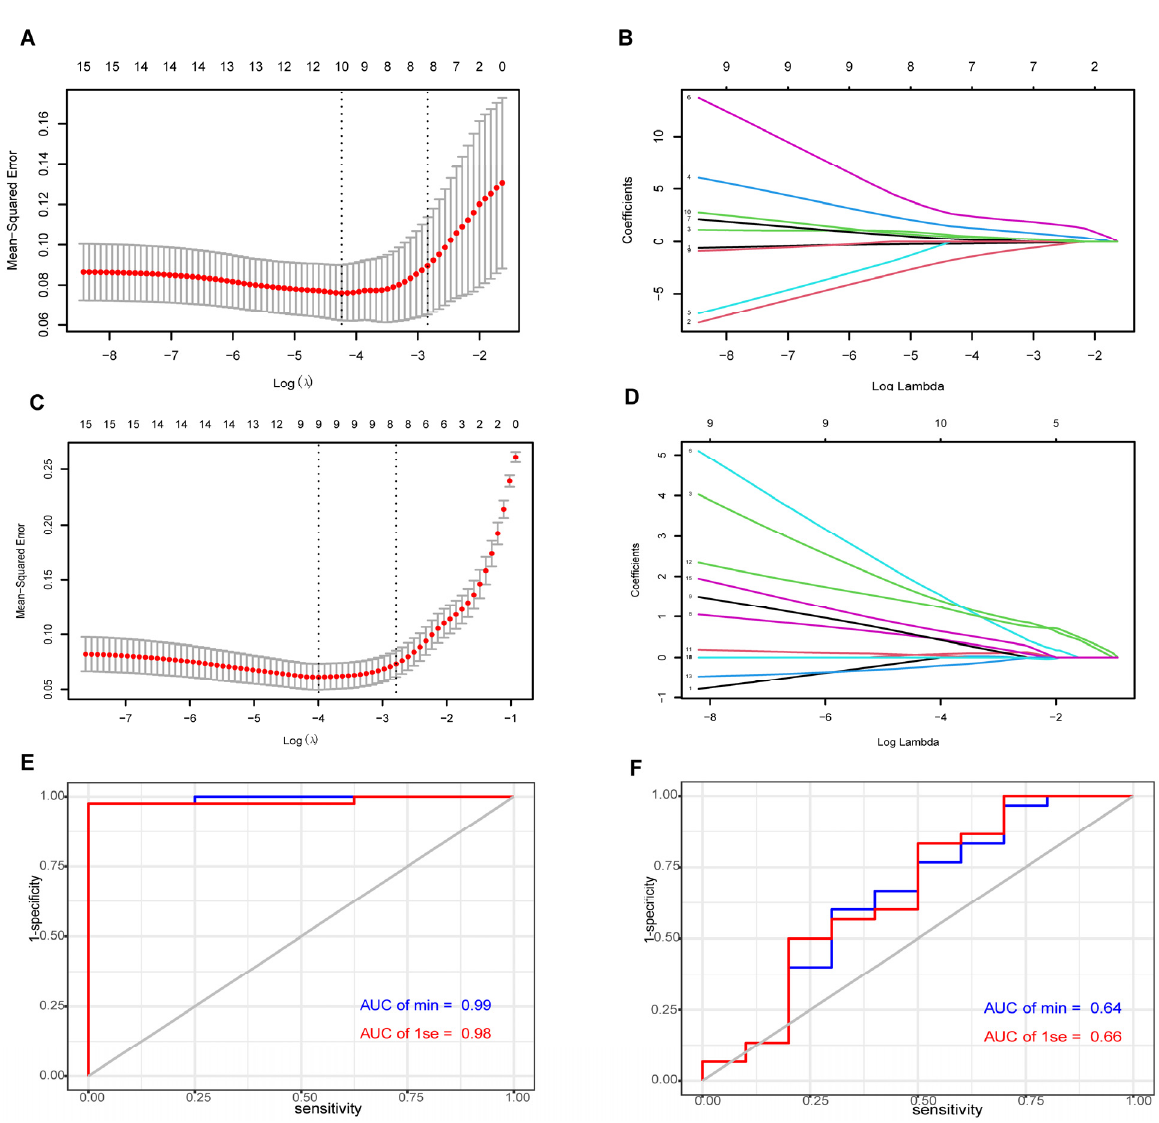
Figure 4. LASSO regression analysis and model discrimination. ( A ) Selection of lambda minimum and 1-SE criteria in the LASSO regression analysis in GSE120895. ( B ) LASSO coefficient profiles of common genes in GSE120895. ( C ) Selection of lambda minimum and 1-SE criteria in the LASSO regression analysis in GSE2508. ( D ) LASSO coefficient profiles of common genes in GSE2508. ( E ) ROC curves for assessing the value of models to diagnose DCM in GSE19303. ( F ) ROC curves for model verification in DCM from GSE19303, grouped by BMI.